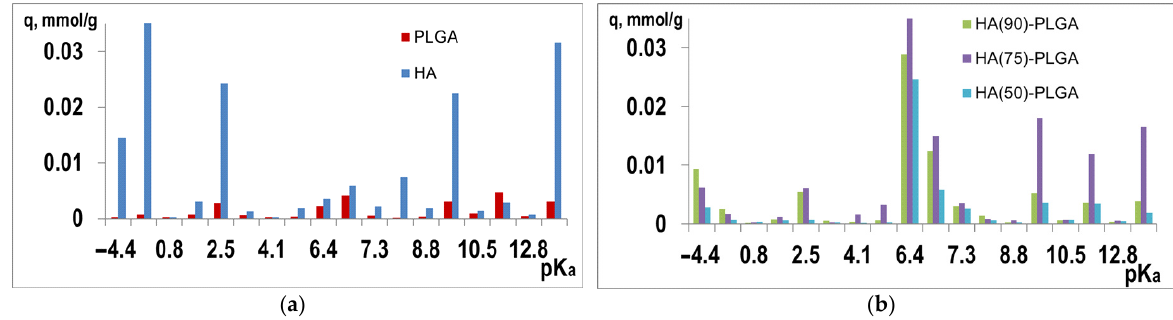
Figure 13. Distribution of ABC (q, mmol/g) ( a ) on the initial components and ( b ) on composites. For all composites and initial components, the contact angle ( θ , °) was determined by the lying drop method. All materials and components are hydrophilic in nature, since θ water < 90° (Table 7). Table 7. Values of the contact angle θ , ° for the initial components and composites of HA-PLGA with water, glycerol. Sample HA PLGA HA (90)-PLGA HA (75)-PLGA HA (50)-PLGA θ water,° 14.1 ± 0.80 θ glycerol,°